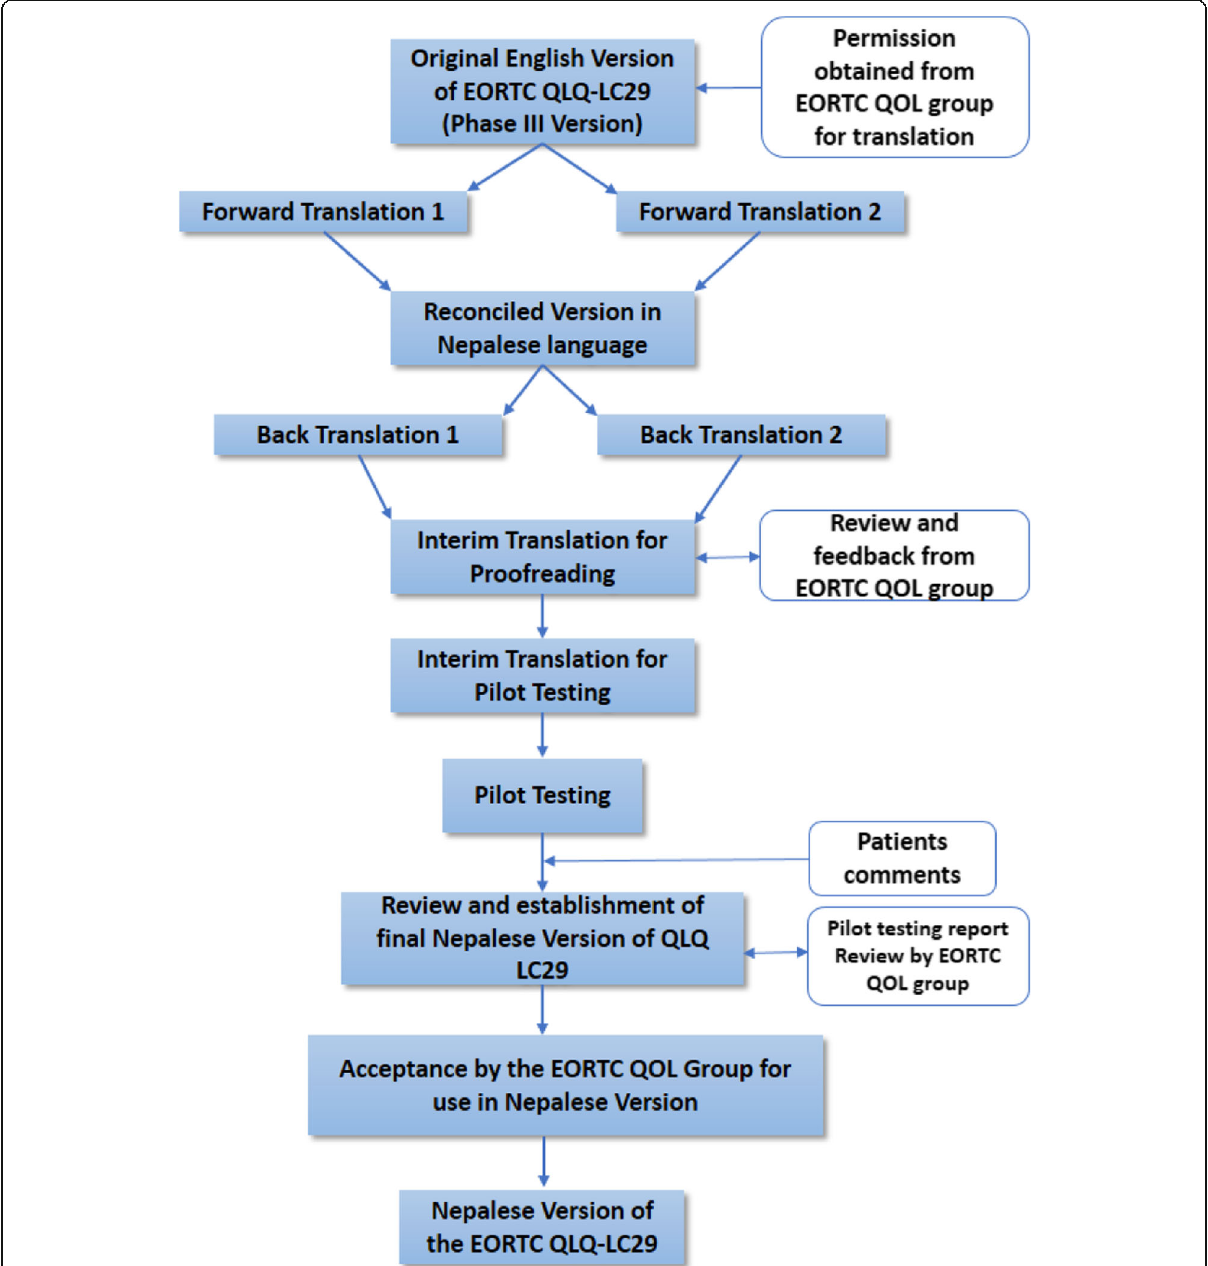
Fig. 1 Translation procedure of EORTC QLQ-LC29 into Nepalese